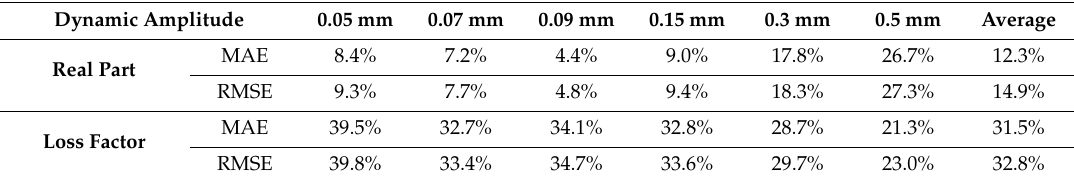
Table 3. Comparison between measured and calculated complex sti ff ness of inflated rubber diaphragm by mean absolute error (MAE) and root mean squared error